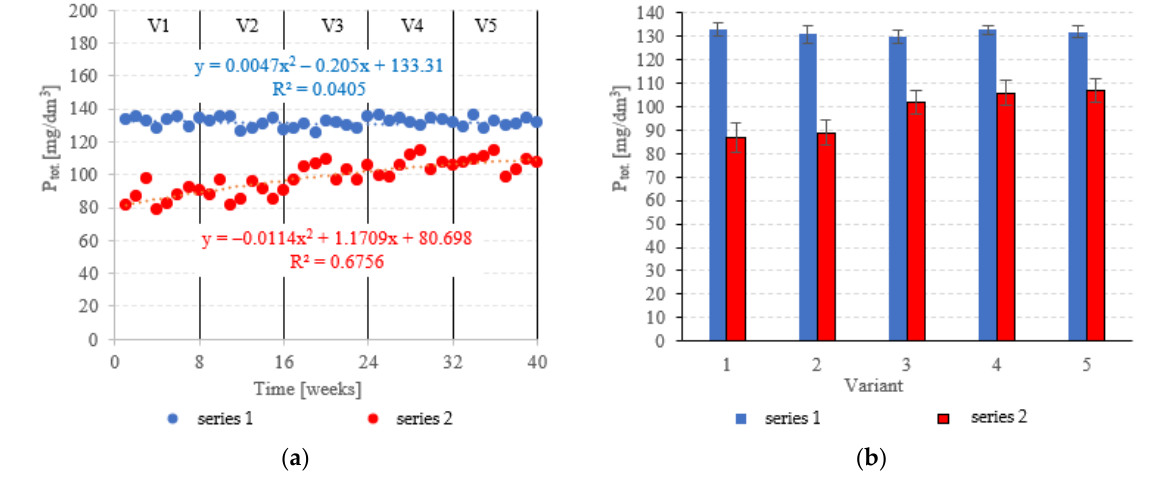
Figure 12. P tot. in the treated effluent (( a ) throughout the experiment; ( b ) average across experimental variants).